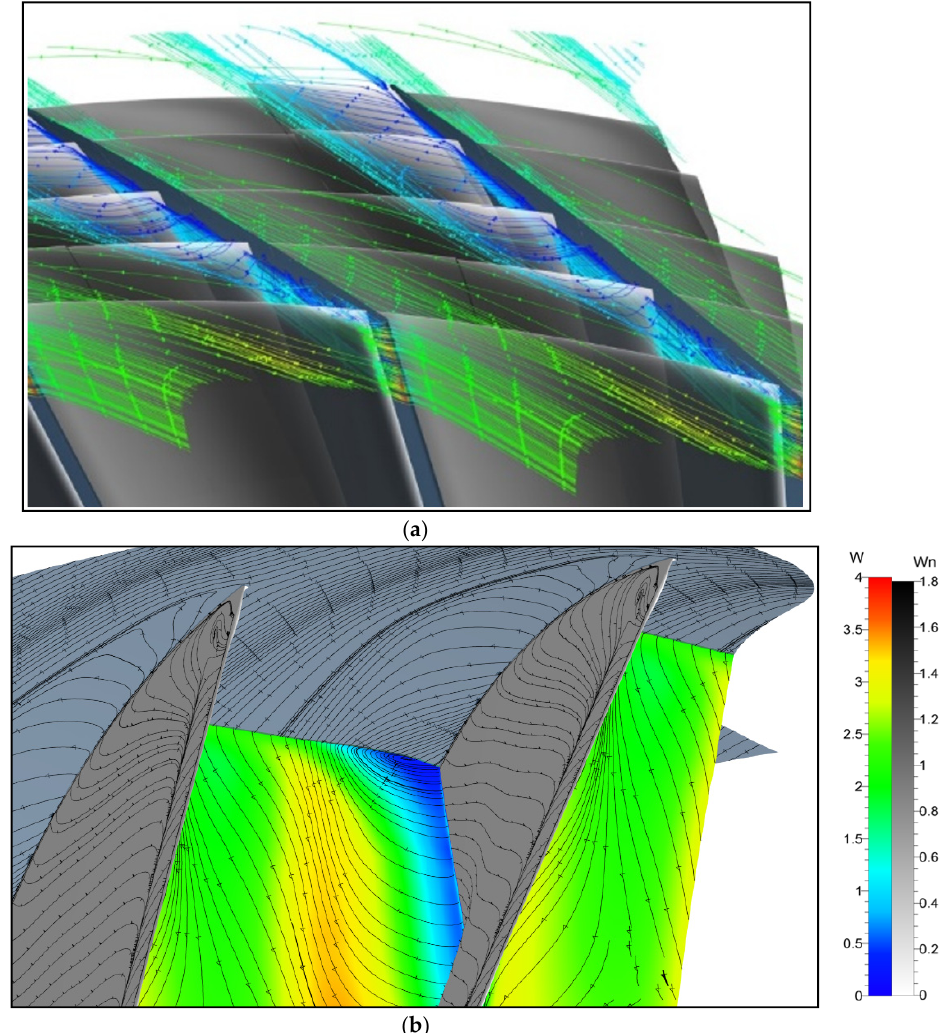
Figure 10. The three-dimensional (3D) figures for the passage flowfield. ( a ): streamlines in tip region with velocity flux contours at passage cutting planes. ( b ): streamlines in tip region with velocity flux contours at passage cutting planes.